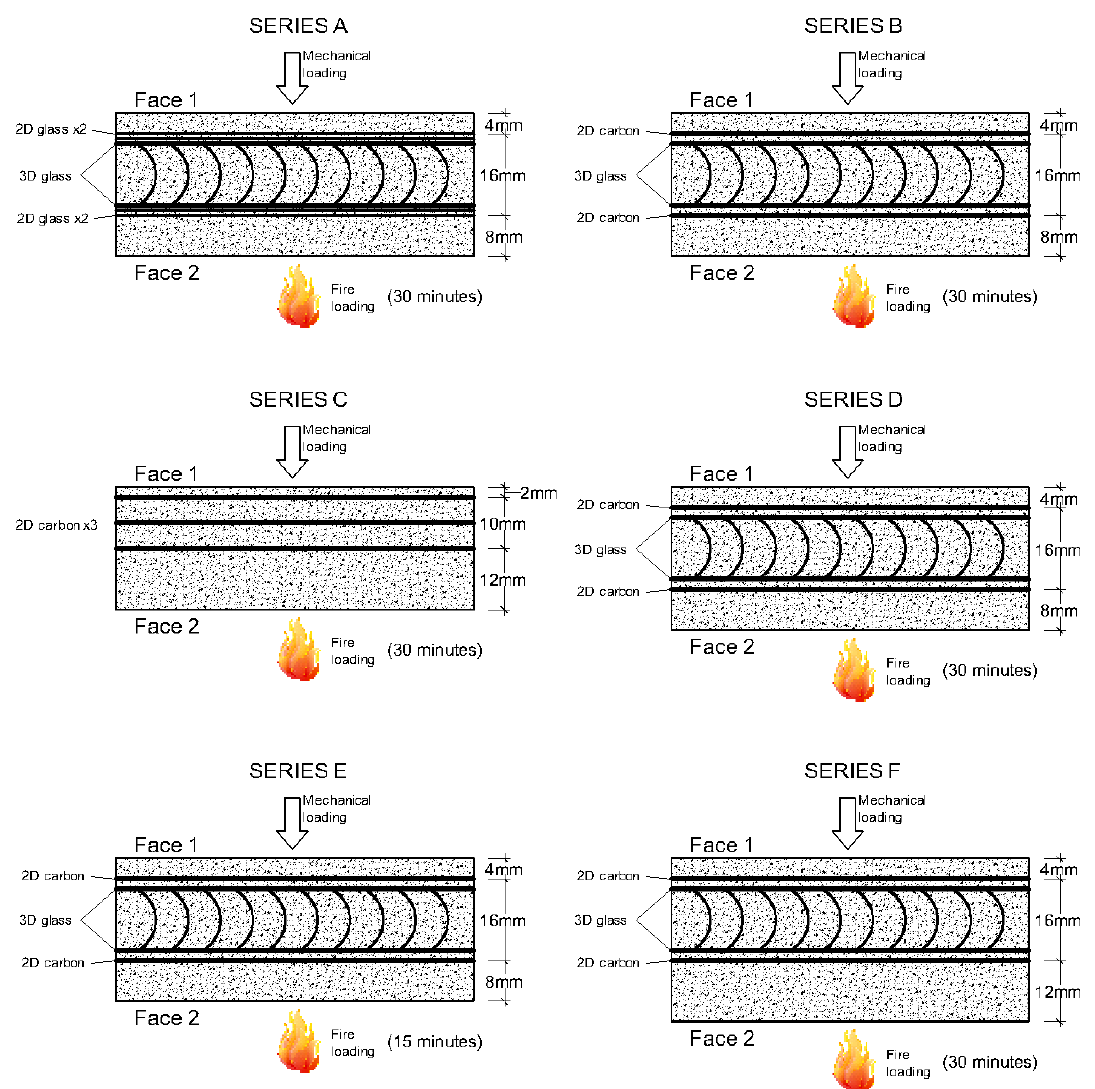
Figure 2. Cross sectional geometry of specimen Series A to F.